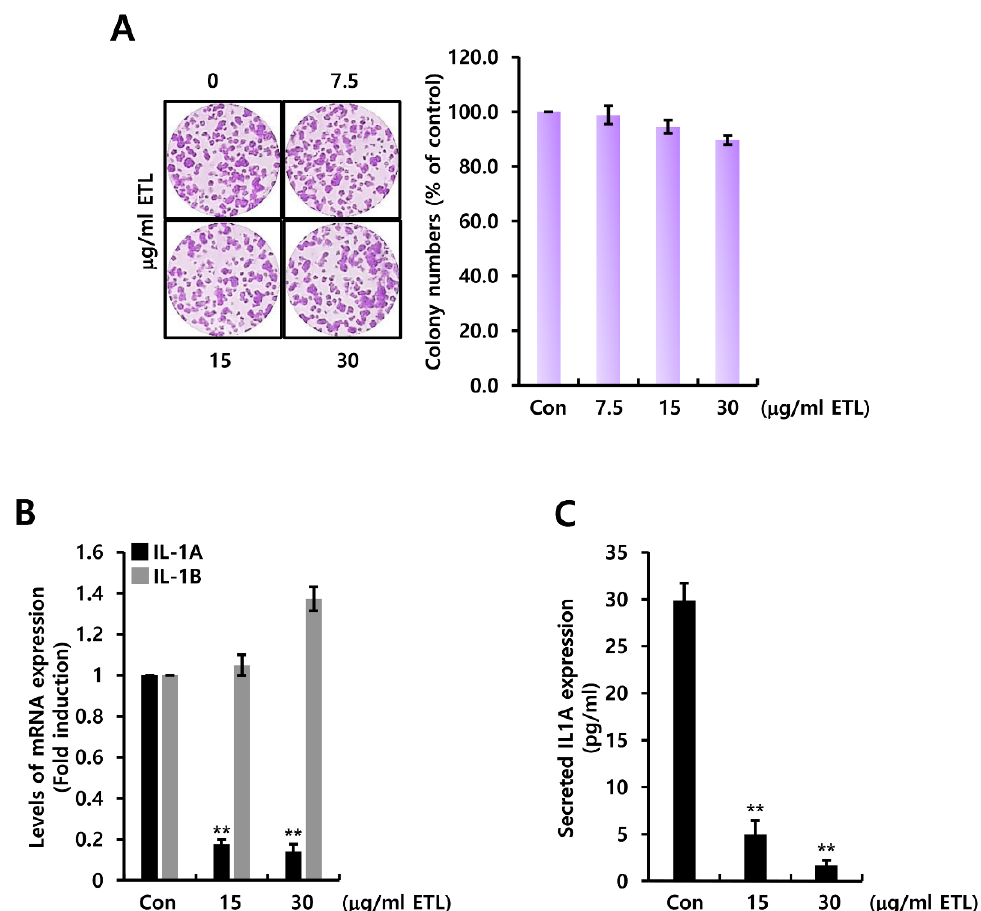
Figure 5. ETL downregulates human IL1A expression in MDA231 TNBC cells. ( A ) after cell-seeding, the indicated concentration of ETL was treated to the cell for two weeks. ( B ) the levels of IL1A and IL1B mRNA were measured by real-time PCR. ( C ) the amount of secreted IL1A protein from conditional culture media was measured by ELISA. The values are presented as the mean ± standard error of three independent experiments. ** p < 0.01 vs. Con. Con; control, ETL; Entelon ® .